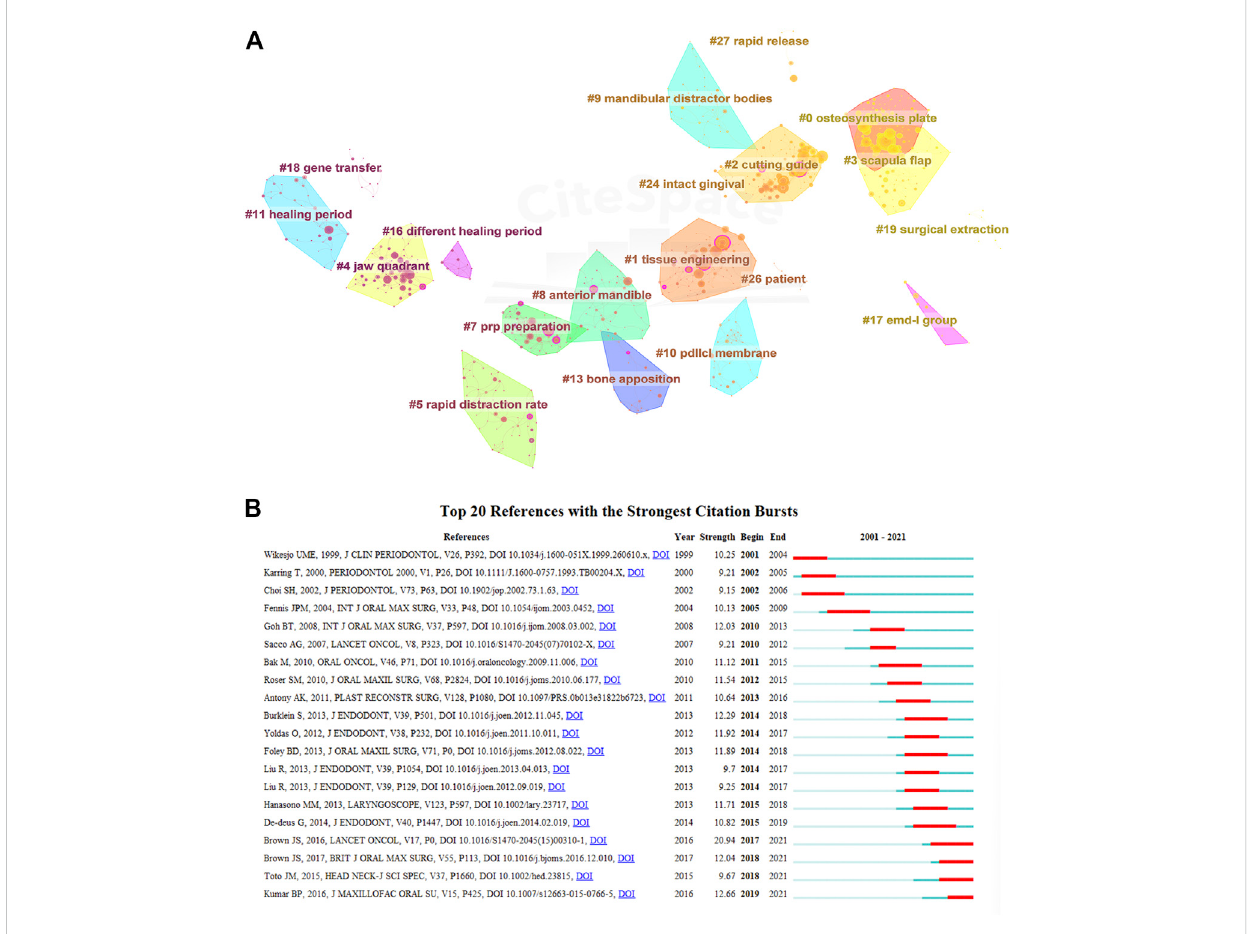
FIGURE 8 Cluster analysis of most commonly cited references of mandibular defect research. (A) Co-citation network of references (modularity Q = 0.8597, Sihouette S = 0.9333). (B) Top 20 references with the strongest citation